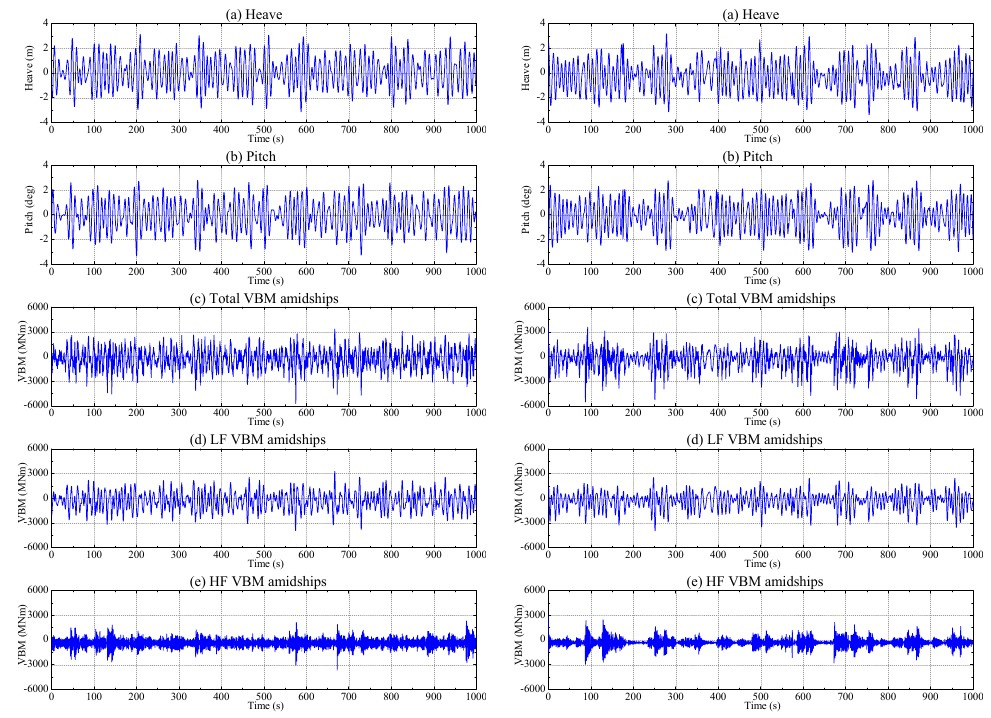
Figure 6. TimeseriesofmotionandloadsinCondition2. ( left )Numericalresults; ( right )experimentalresults.